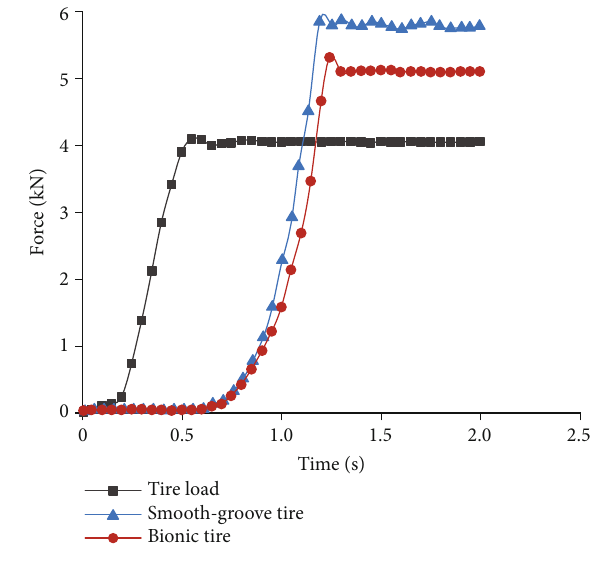
Figure 14: Hydrodynamic